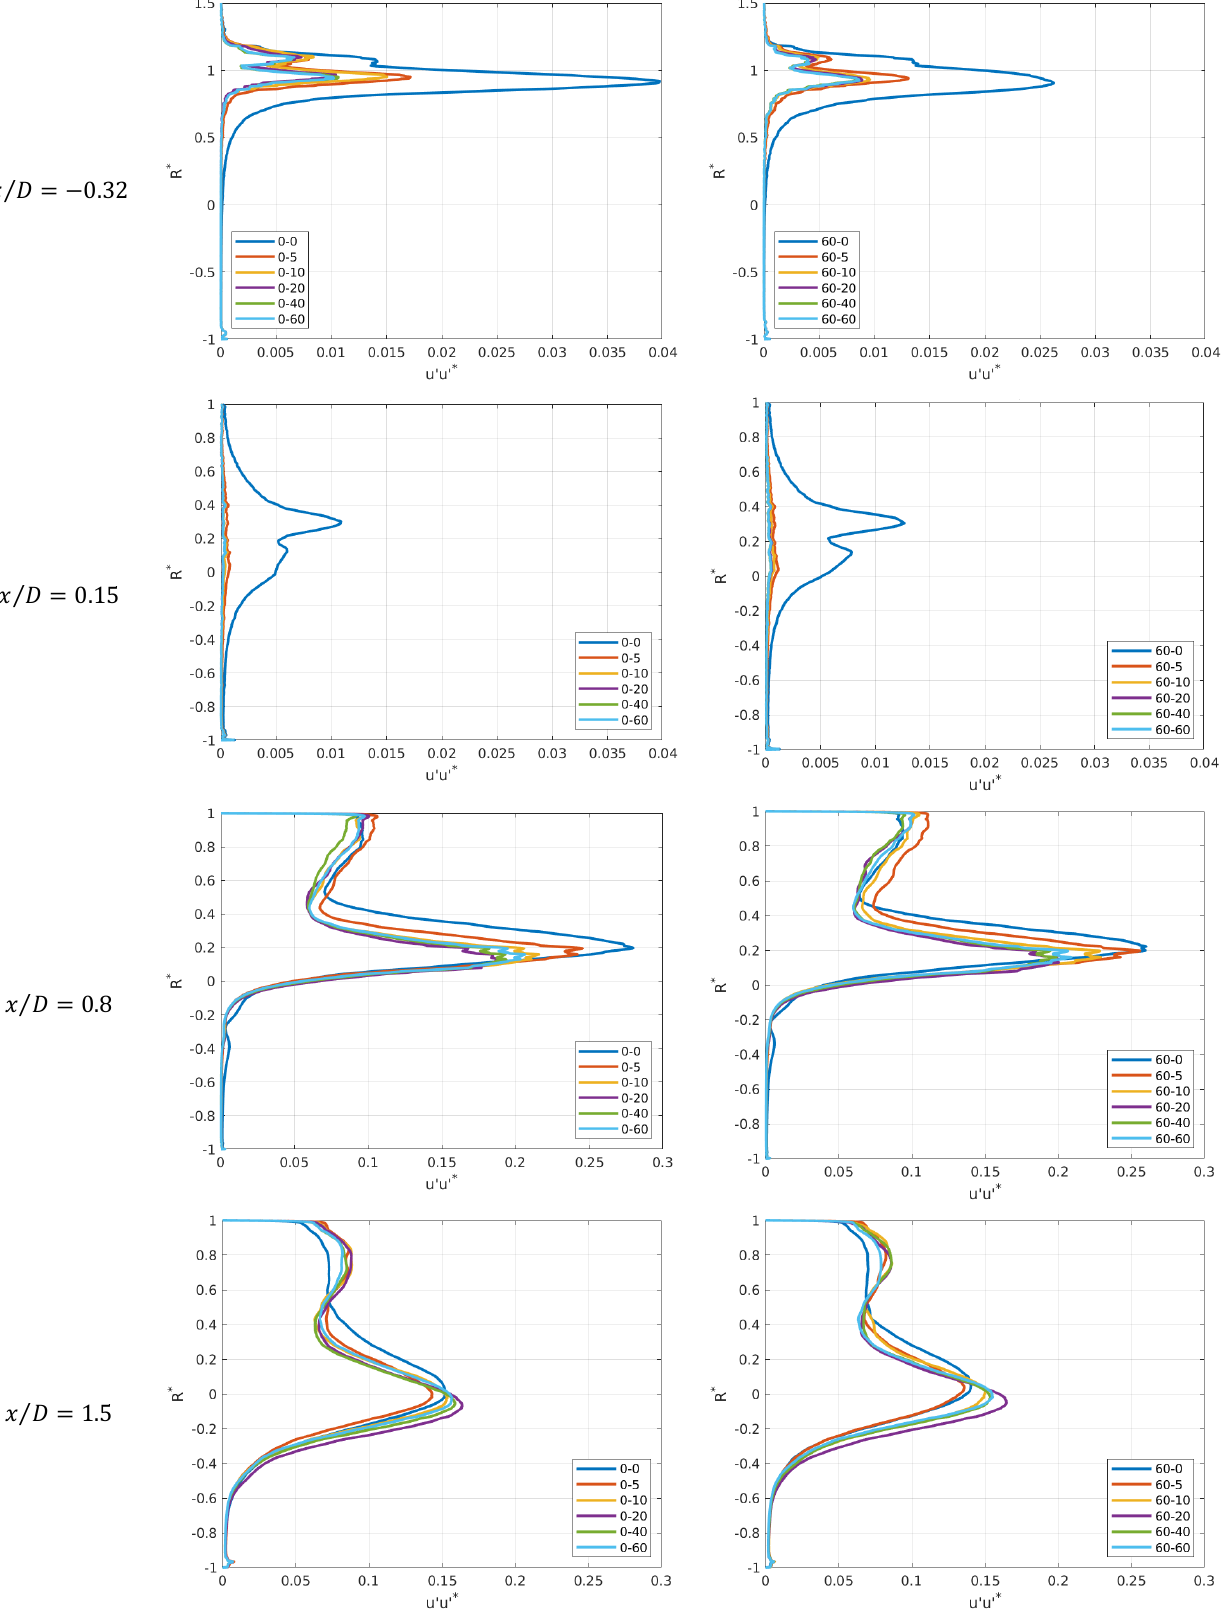
Figure 10. Vertical profiles of 𝑢 (cid:4593) 𝑢 (cid:4593)∗ at different cross-sections.